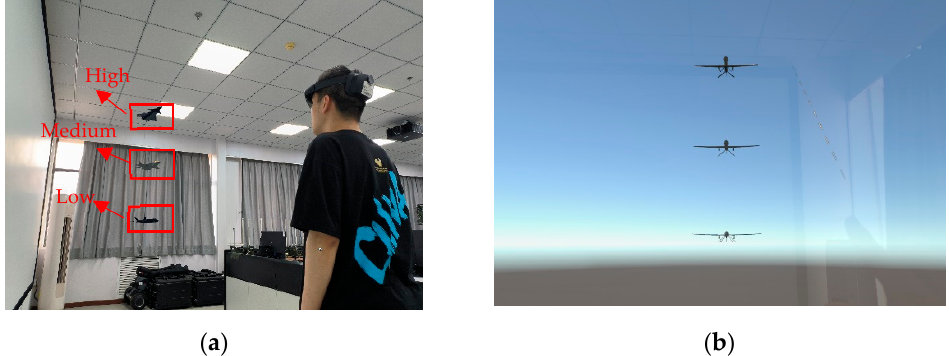
Figure 2. Scenes from experiment 1. ( a ) Schematic diagram of the virtual-real scene; ( b ) Range of height of field of view in MR.